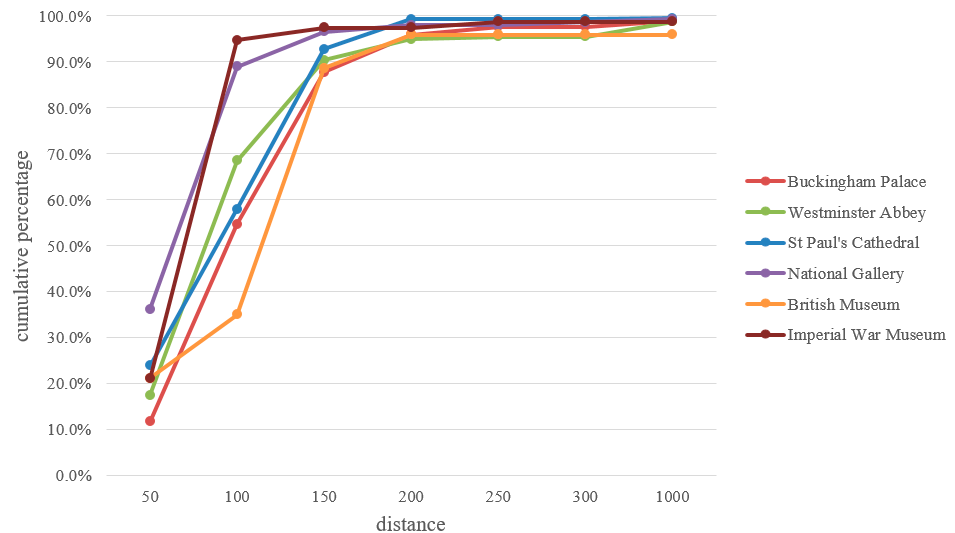
Figure 12. Cumulative-count-distribution graph of distance between images and landmarks.